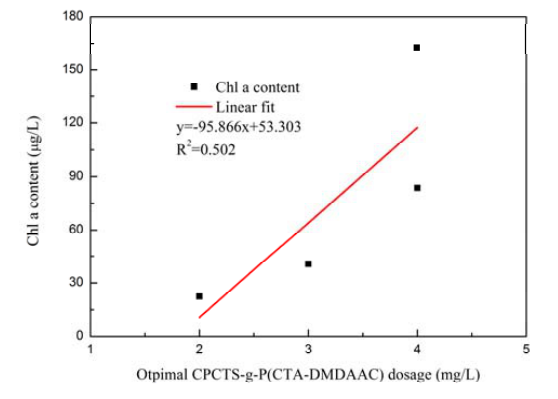
Figure 9. Relationship between optimal CPCTS ‐ g ‐ P (CTA ‐ DMDAAC) dosage and Chl ‐ a content.